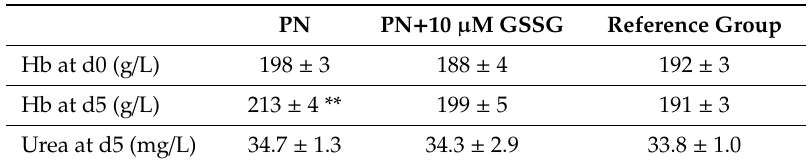
Table 2. Haemoglobin and plasma urea concentrations. Hb: haemoglobin measured on the first (d0) and last (d5) day of experimentation. Urea measured in plasma at the last day of experimentation. At d0, there was no di ff erence in Hb between groups, while at d5 it was higher in PN group compared to PN + GSSG and reference groups. Urea concentrations were not significantly di ff erent between